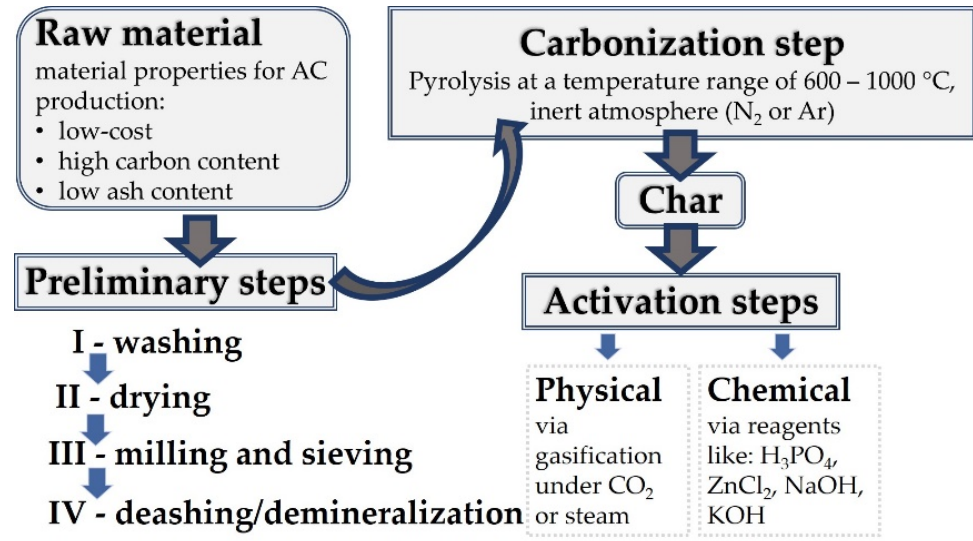
Figure 1. Pathway of activated carbon formation.